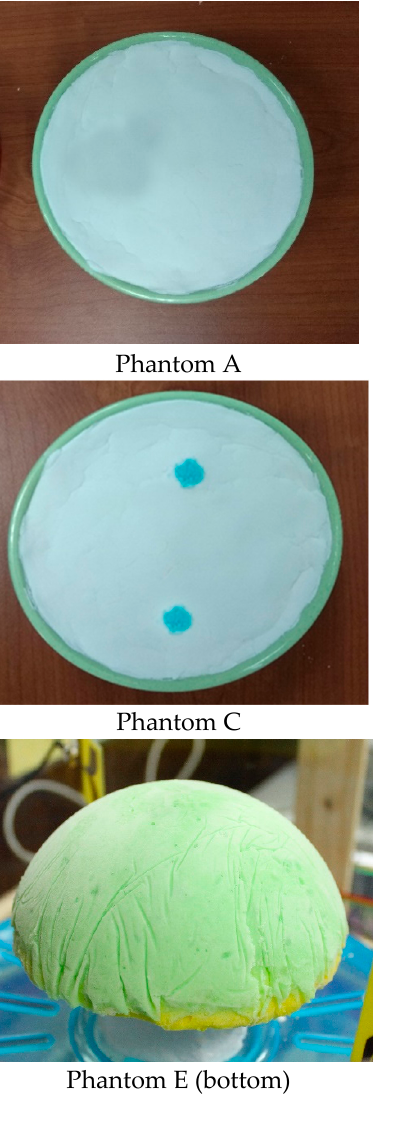
Figure 12. The architecture and a different component of the proposed experimental breast imaging system; ( a ) block diagram ( b ) breast phantoms.